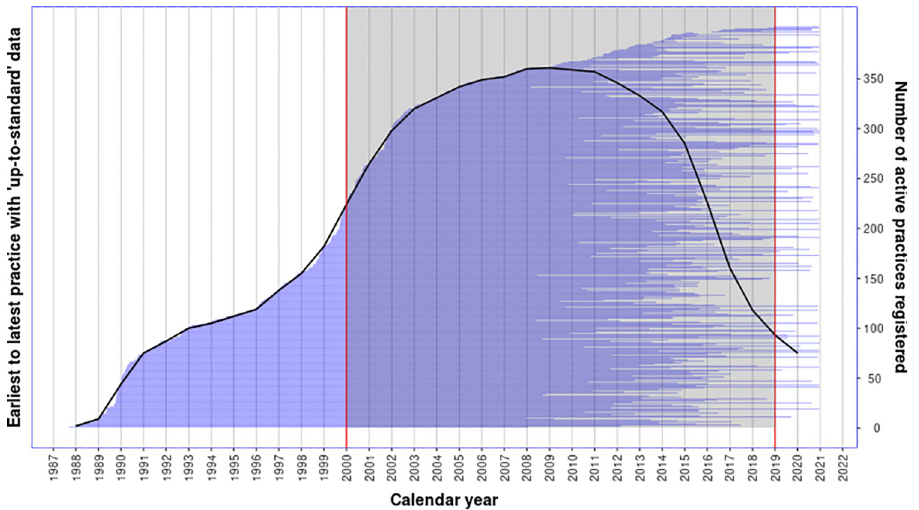
Fig 2. CPRD practice data contribution history for GP practices associated with the 1 million random patient sample, from up-to-standard date to date of last data collection . The shaded region shows the follow-up period with the number of active practices by calendar year overlaid (right-hand y-axis).